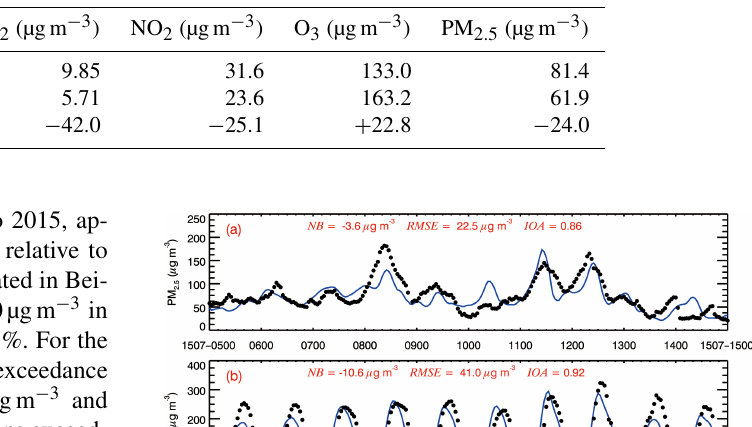
Table 2. Hourly mass concentrations of pollutants averaged in the afternoon at 12 monitoring sites in Beijing during summertime of 2013 and 2015.